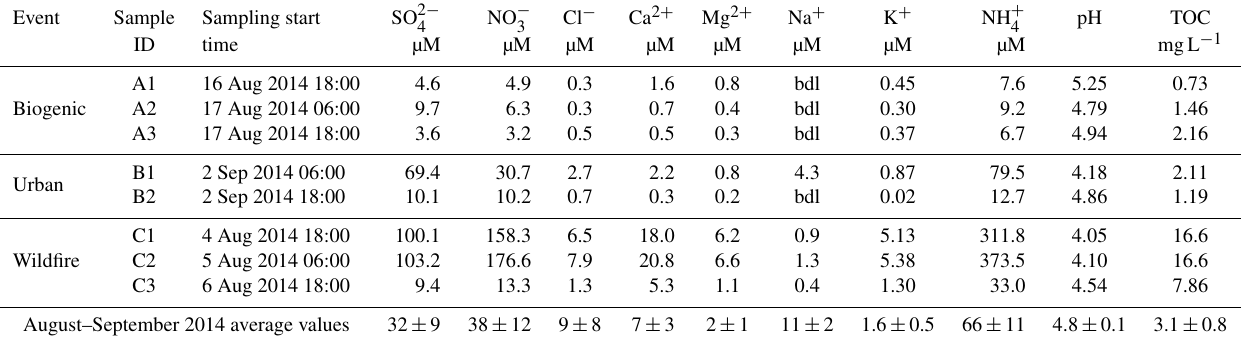
Table 1. Summary of the sampling times, as well as inorganic ion concentrations, pH, and TOC concentrations, for cloud water samples from the Whiteface Mountain Observatory. Cloud water samples were collected with 3h resolution (local time: EDT). Values below the method limit of detection for Na + are noted as “bdl”. The 95% confidence intervals are shown for August–September 2014 averages. Event